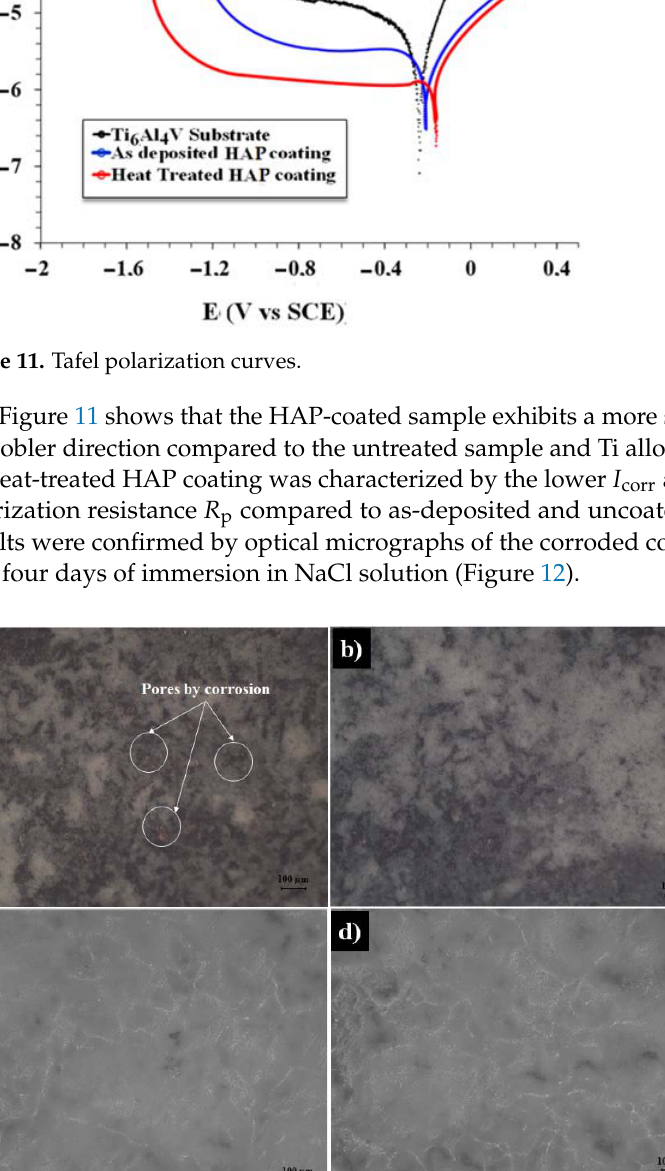
Figure 12. Optical micrograph of corroded samples: ( a,b ) as-deposited and heat-treated ( c , d ) HAP coatings.